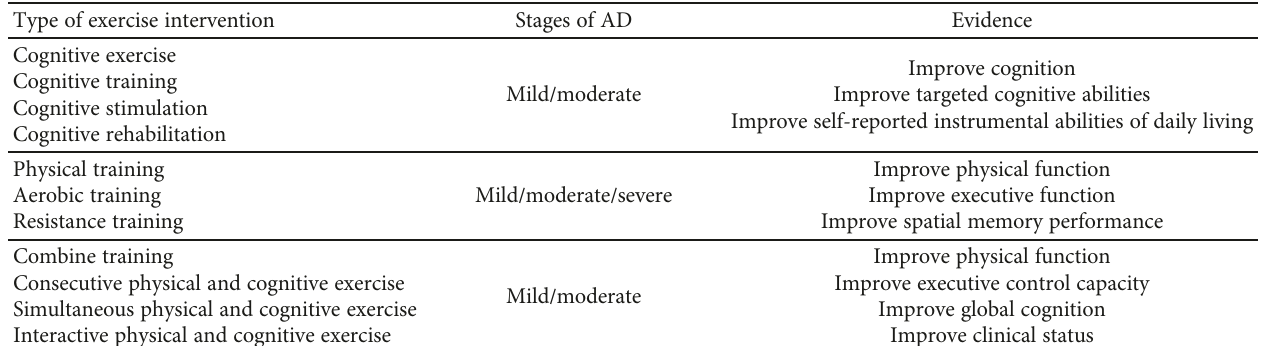
Table 1: Exercise management of Alzheimer ’ s